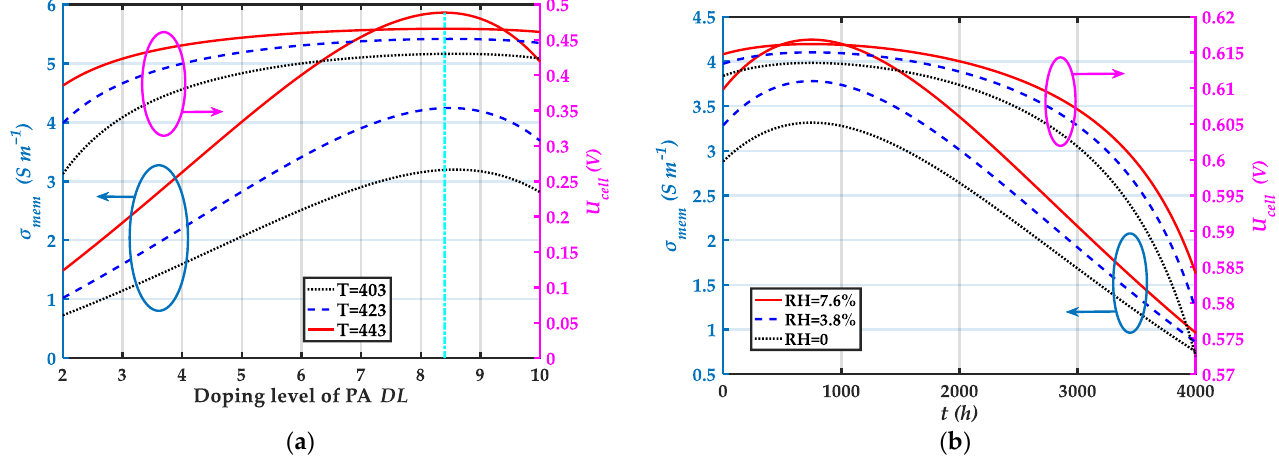
Figure 3. Variation of proton conductivity of the membrane σ mem and reversible output voltage of the HT-PEMFC single cell U cell with DL and t : ( a ) Variation of σ mem and U cell with DL ; ( b ) Variation of σ mem and U cell with t .